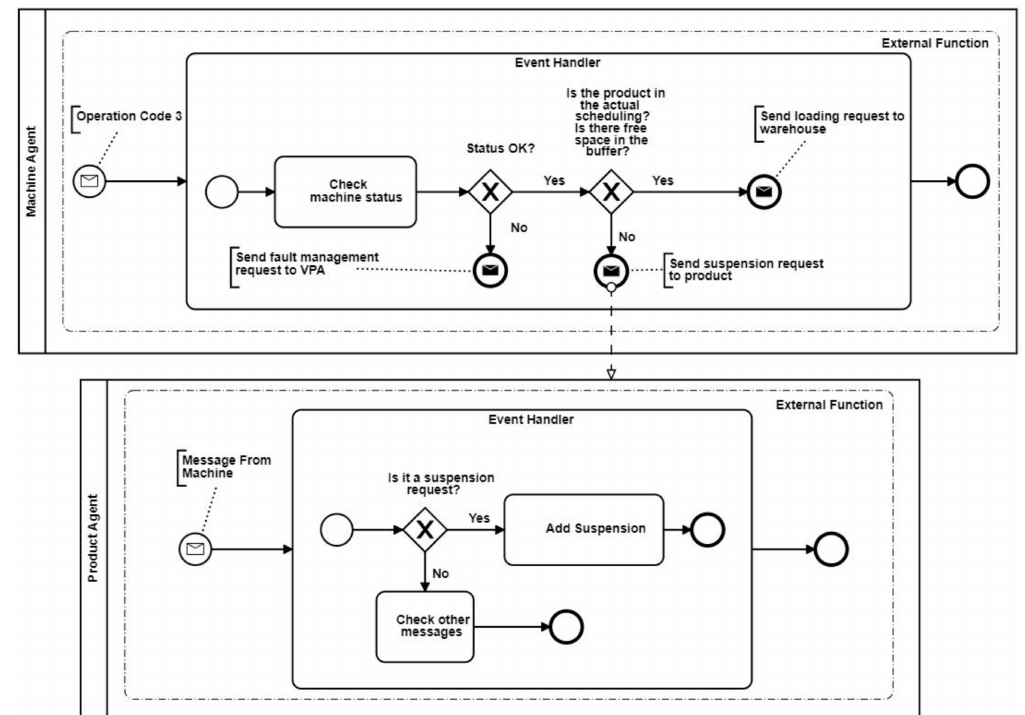
Figure 5. Interaction between Machine Agent and Product Agent when the operation 003